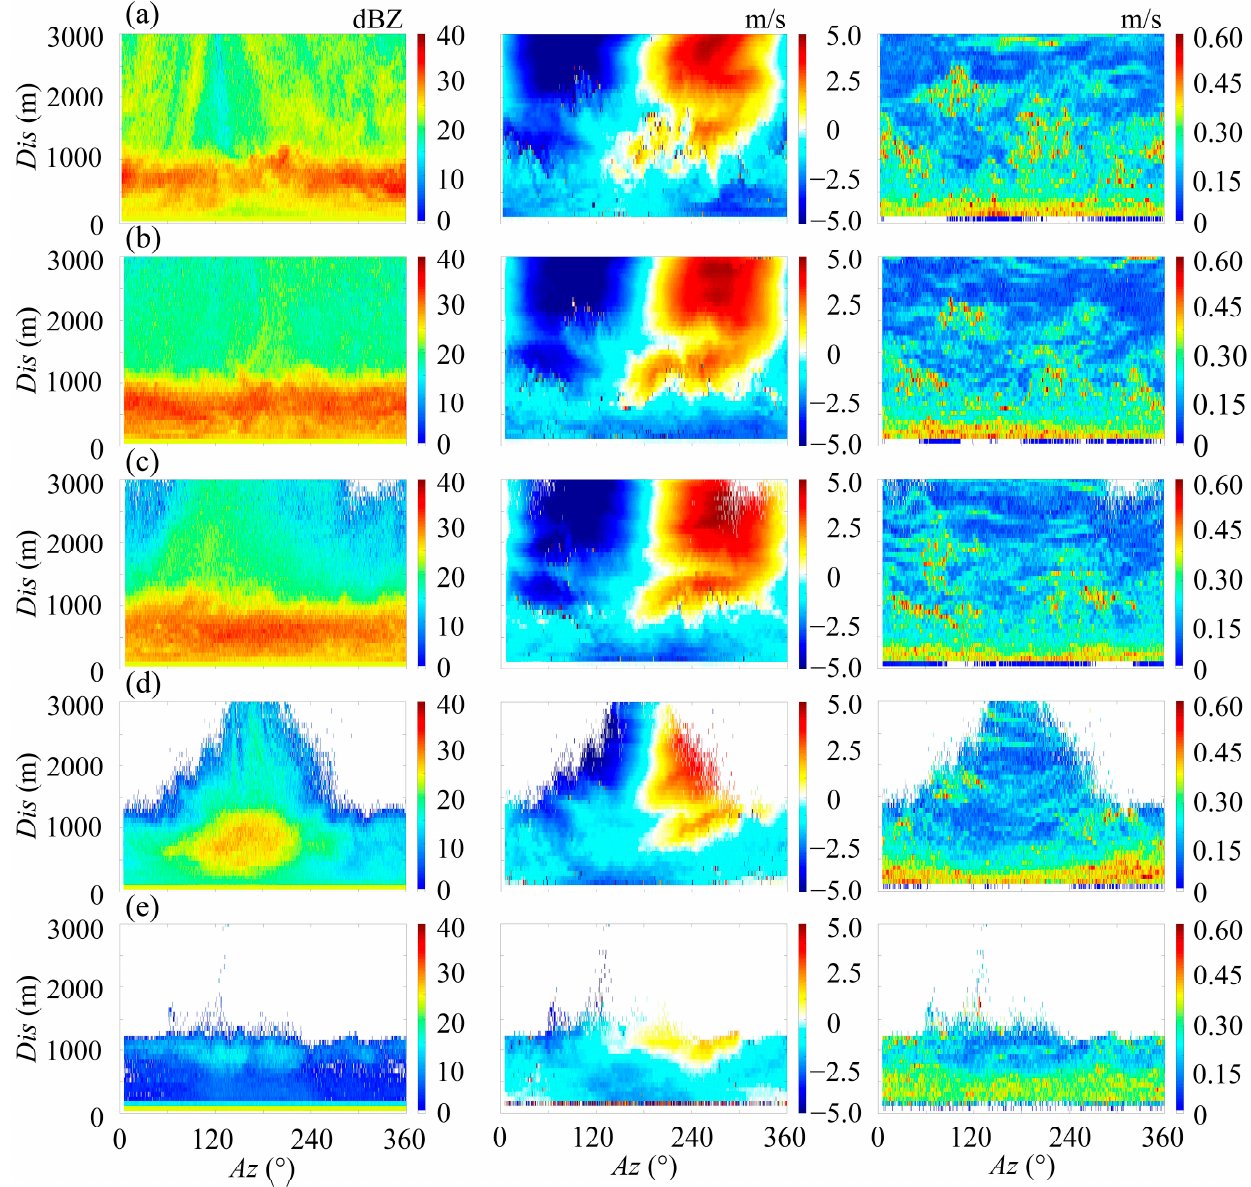
Figure 6. Temporal evolution of Z measured by cloud and weather radar instruments in the Ka band (Plan Position Indicator, or PPI mode, pitch angle = 21.8°). The angle interval covered by the dashed window is the radar azimuth angle in the Range Height Indicator, or RHI mode. ( a ) t 1 = 6:40, ( b ) t 2 = 7:00, ( c ) t 3 = 7:20, ( d ) t 4 = 7:40, ( e ) t 5 = 8:00. The legend represents Z , V r and W from left to right.